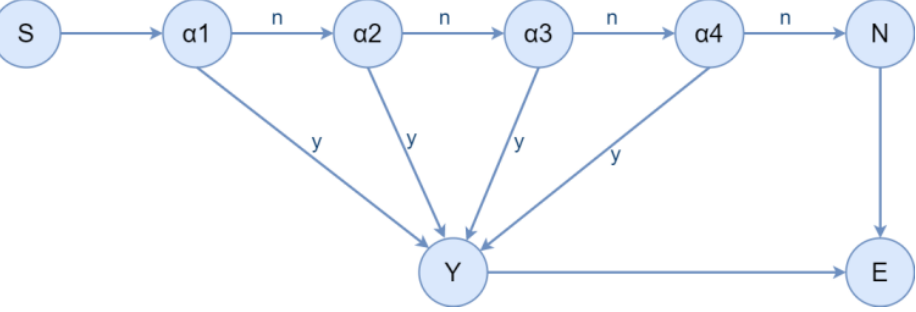
Figure 9. A flow-control graph describing a BDI program, adapted from